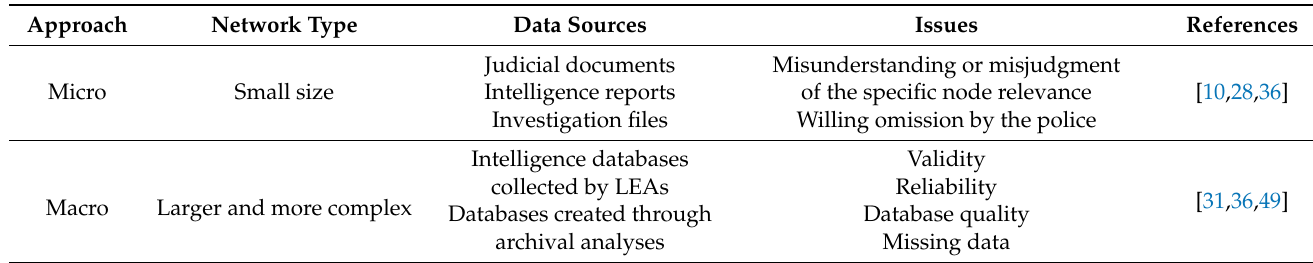
Table 1. Key references about data management in covert